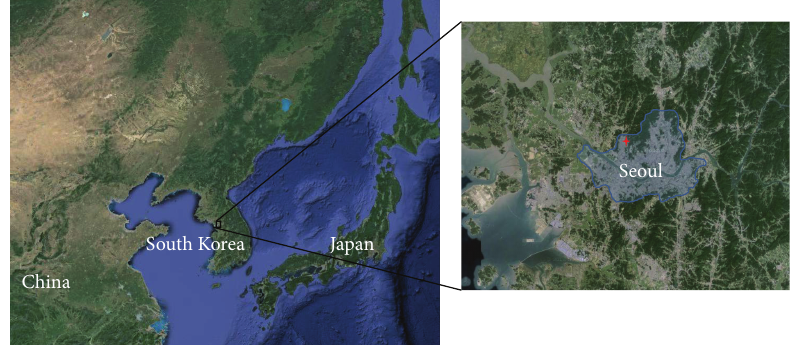
Figure 1: The location of monitoring